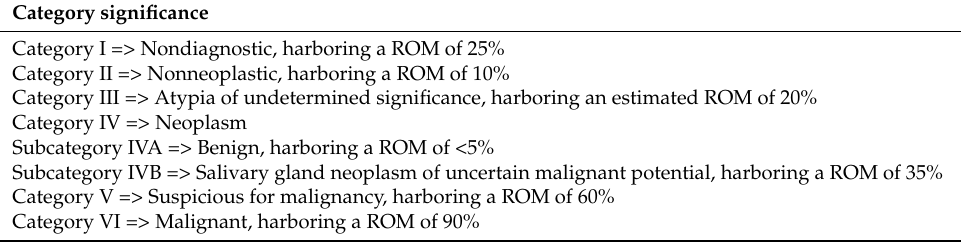
Table 1. Milan System for Reporting Salivary Gland Cytology (adapted from [36]).